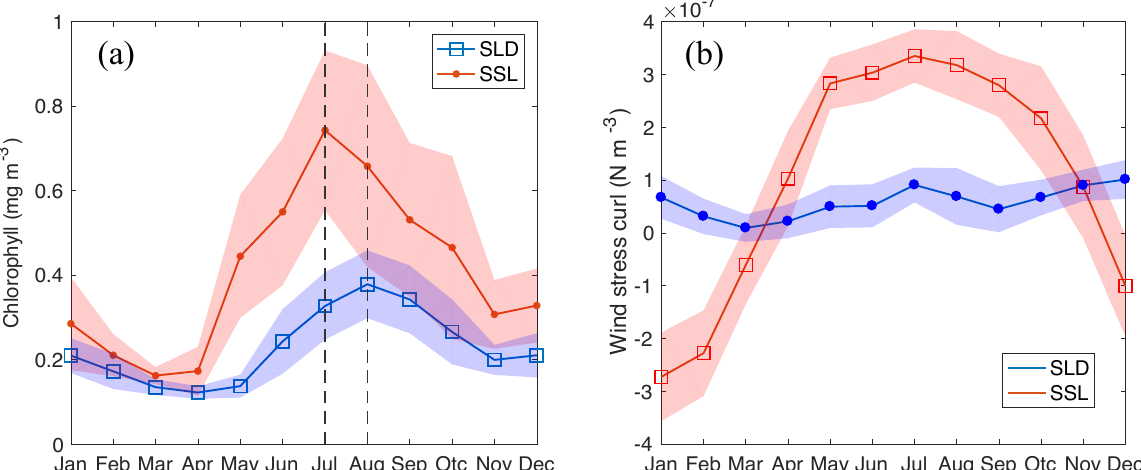
Figure 3. Monthly climatology of ( a ) chlorophyll and ( b ) wind stress curl averaged in the SLD and SSL box. Dash lines in ( a ) denote the month of maxima occurring in the SLD and SSL box. Shading denotes the range of standard deviation of each month.